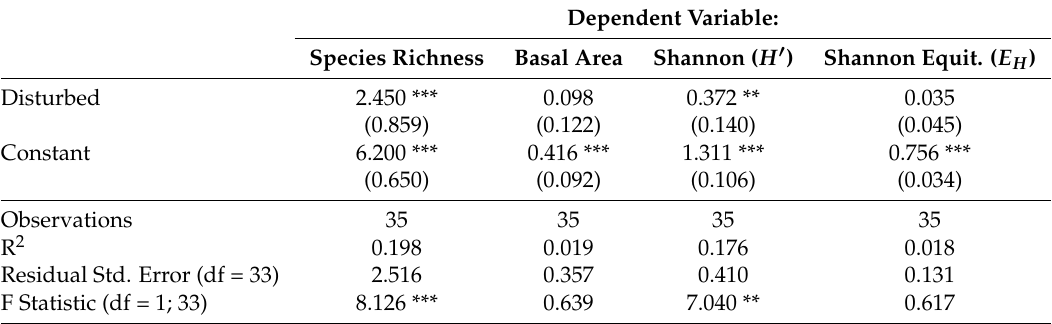
Figure 7. The variation in diversity and woodland structure between disturbed and undisturbed 20 × 50 m (0.1 ha) plots in Bicuar National Park. Boxes bound the 1st and 3rd quartiles, with the median within the box. Whiskers represent 1.5 times the interquartile range plus or minus the 1st and 3rd quartiles, respectively. Values found beyond the whiskers are shown individually as points. Table 5. Results of ANOVA tests for alpha diversity metrics and plot basal area, between disturbed and undisturbed plots in Bicuar National Park. Mean values for each group of plots with standard errors in parentheses are shown. Asterisks indicate the p -value of individual sites in each ANOVA (*** <0.001, ** <0.01, * <0.05, .